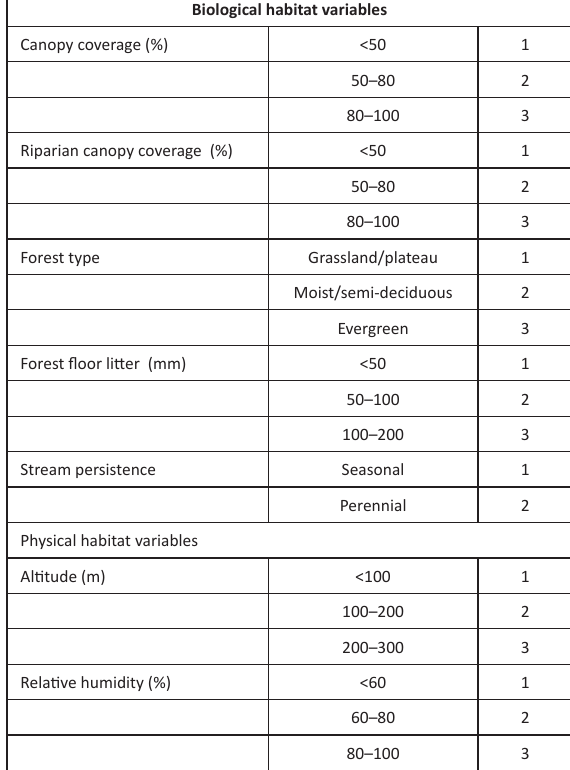
Table 2. Biological and physical habitat variables guild gradation for anurans recorded in study area. Biological habitat variables